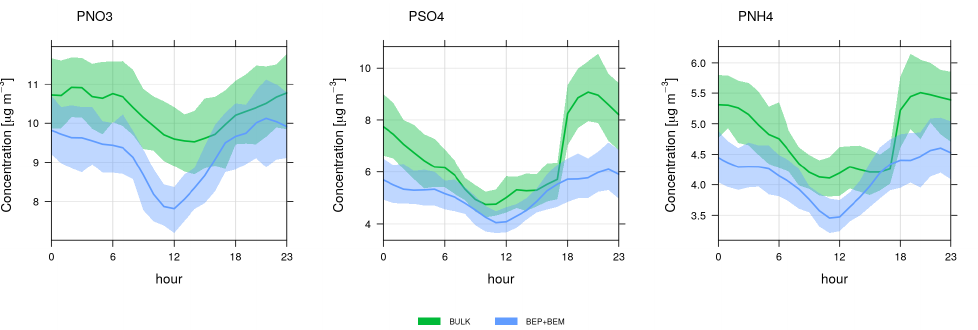
Figure 11. Averaged diurnal profiles of PM secondary inorganic aerosol (nitrates-PNO 3 , sulfates-PSO 4 , and ammonium-PNH 4 ) for BULK simulations (green) and BEP+BEM simulations (blue). Lines represent the mean values and shaded areas the 95% confidence interval in the mean.